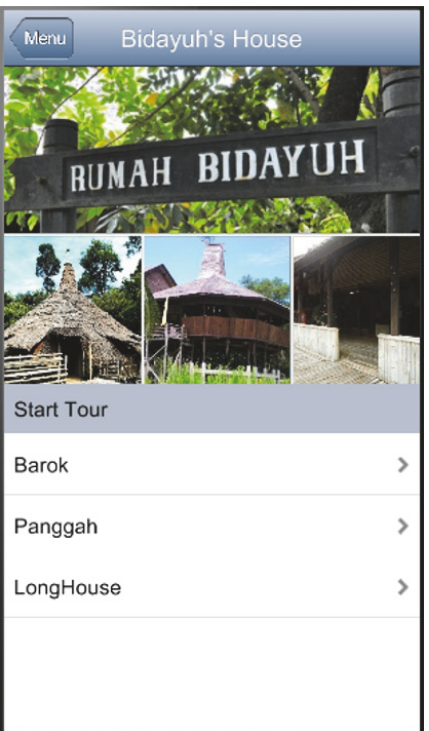
Figure 7: Main menu of the Bidayuh House.